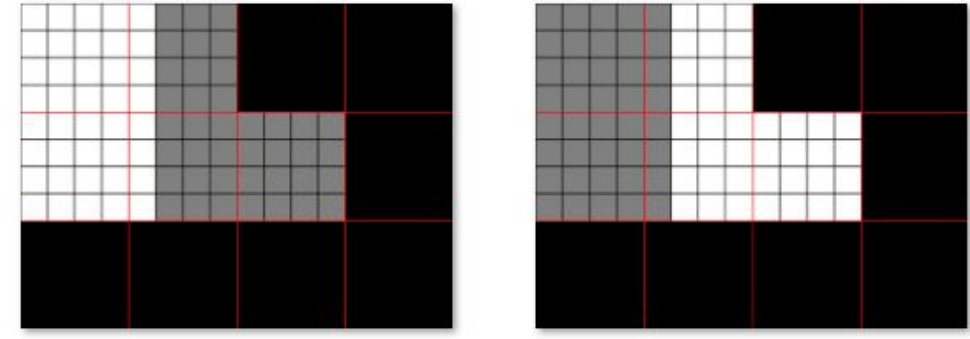
Figure 18. Min Group: A/S = 1.01 with 2 models